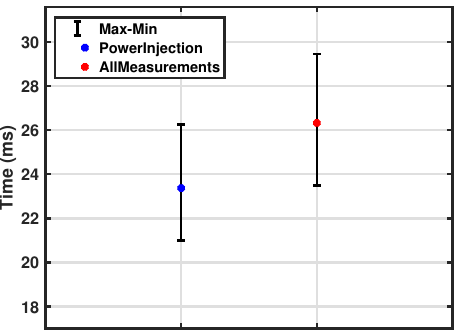
Figure 15. The time performance of two sets of measurements in a unified state